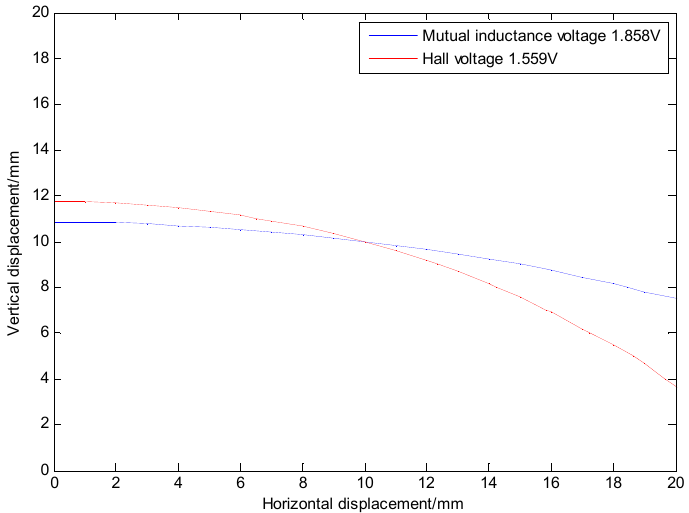
Figure 13. Intersection of two contours when the horizontal displacement and the vertical displacement are both 10 mm.